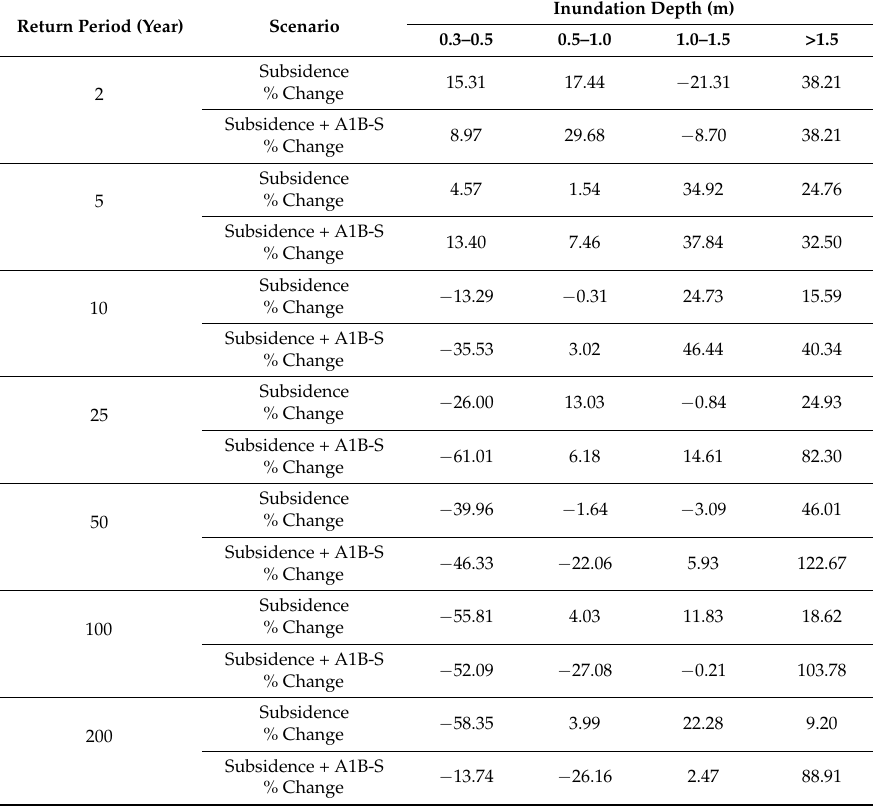
Table 7. Percentage of inundation area increase for two-day storm under different return periods and